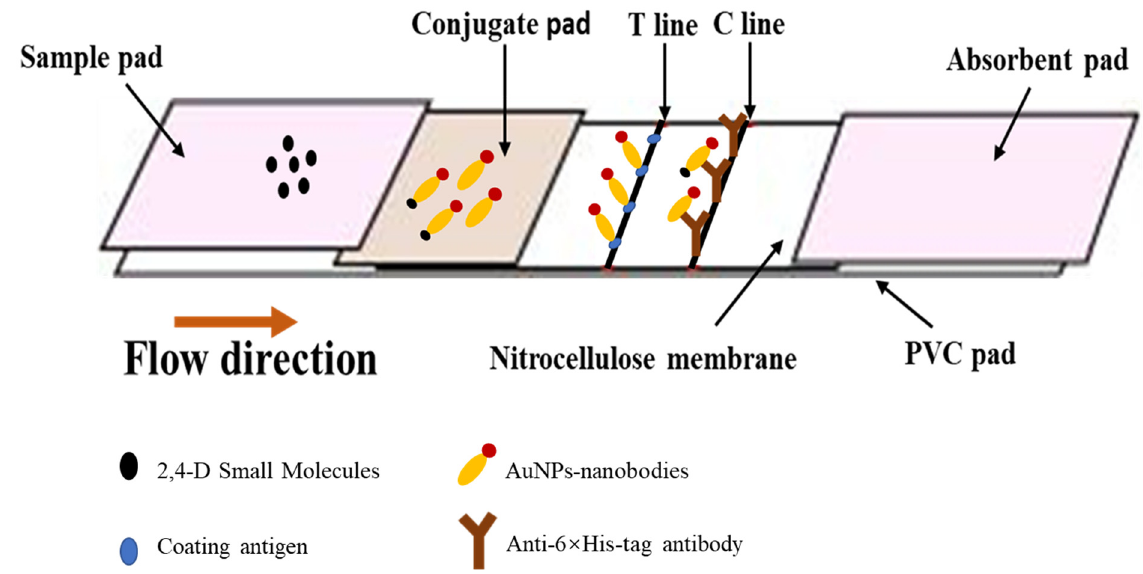
Figure 1. Assembly of test strips and principles of immunochromatography.